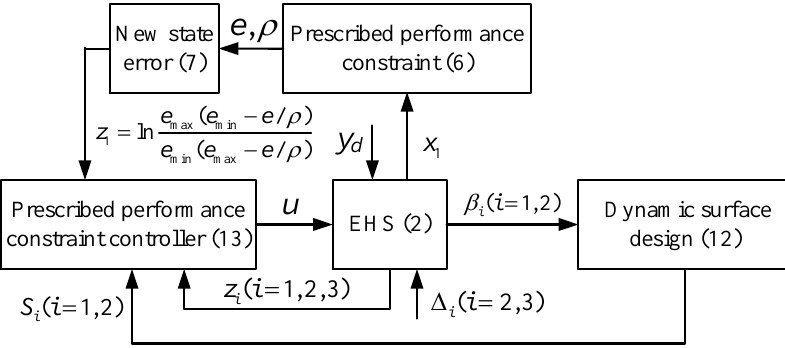
Figure 2. Block diagram of the prescribed performance constraint